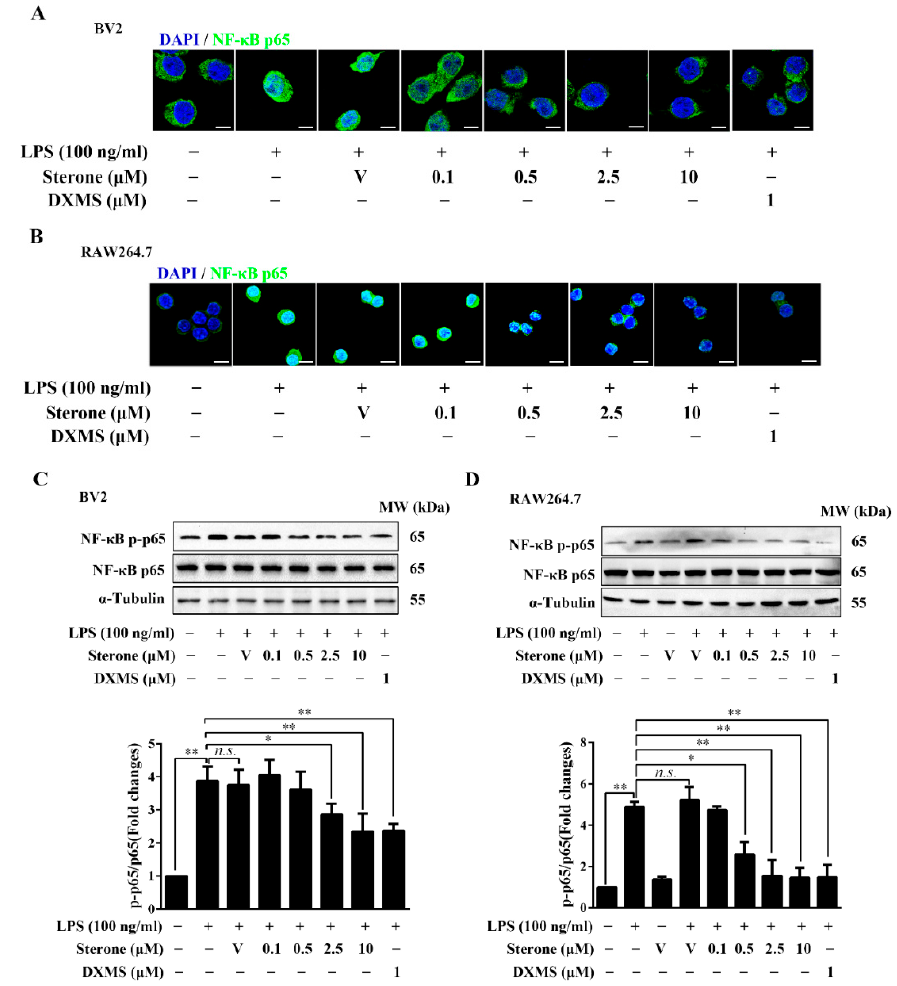
Figure 3. Sterone inhibited LPS-induced NF- κ B activation in BV2 cells and RAW264.7 cells. Cells were pre-treated with the indicated concentrations of sterone or DXMS for 30 min before the stimulation by 100 ng/mL LPS for 30 min individually. The nuclear localization of NF- κ B p65 in BV2 cells ( A ) and RAW264.7 cells ( B ) were measured using immunofluorescence stain with an NF- κ B p65 antibody (Green) and nuclear stain by 4 ′ ,6-Diamidino-2-phenylindole (DAPI, blue). The phosphorylation levels of NF- κ B p65 in BV2 cells ( C ) and RAW264.7 cells ( D ) were measured using western blotting. V, Vehicle (HP- β -CD). Scale bars, 10 μ m. Values are mean ± SD of three independent experiments. n.s, no significance. * p < 0.05, ** p < 0.01.